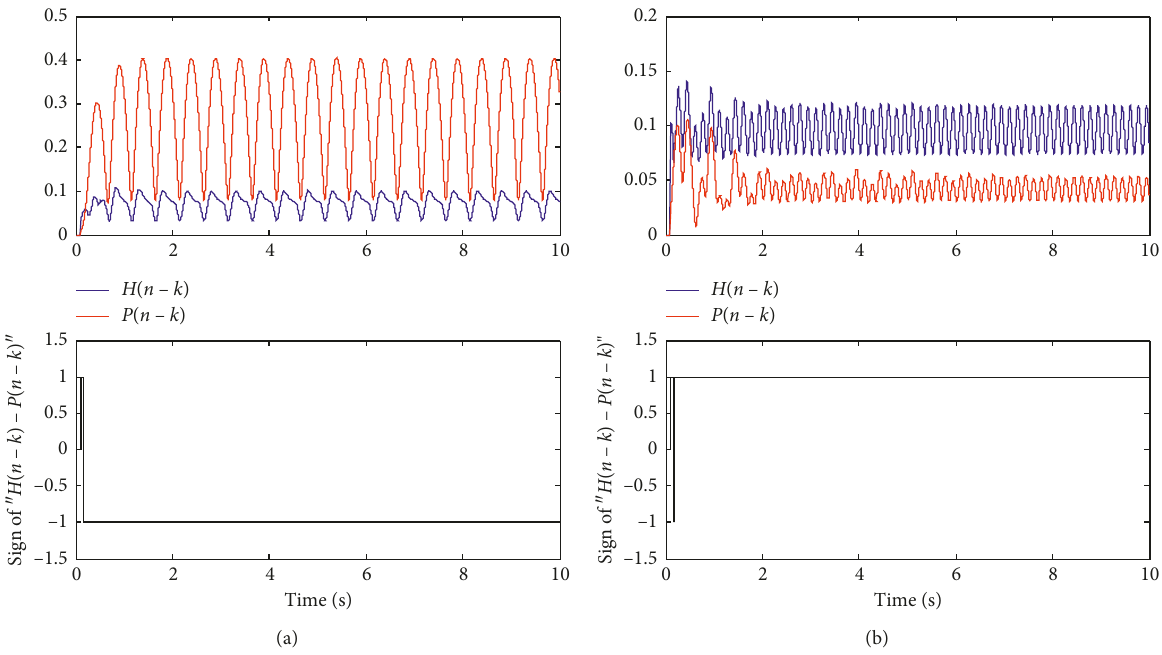
Figure 13: Judgment results of EMA frequency-range selector. Road excitation frequency of (a) 2 π and (b) 6 π